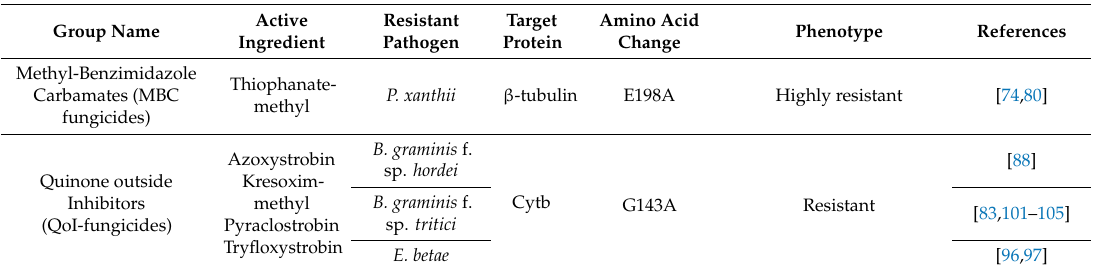
Table 3. Amino acid changes in target proteins and other molecular mechanisms related with fungicide resistance to MBC fungicides, QoIs, DMIs and SDHIs in powdery